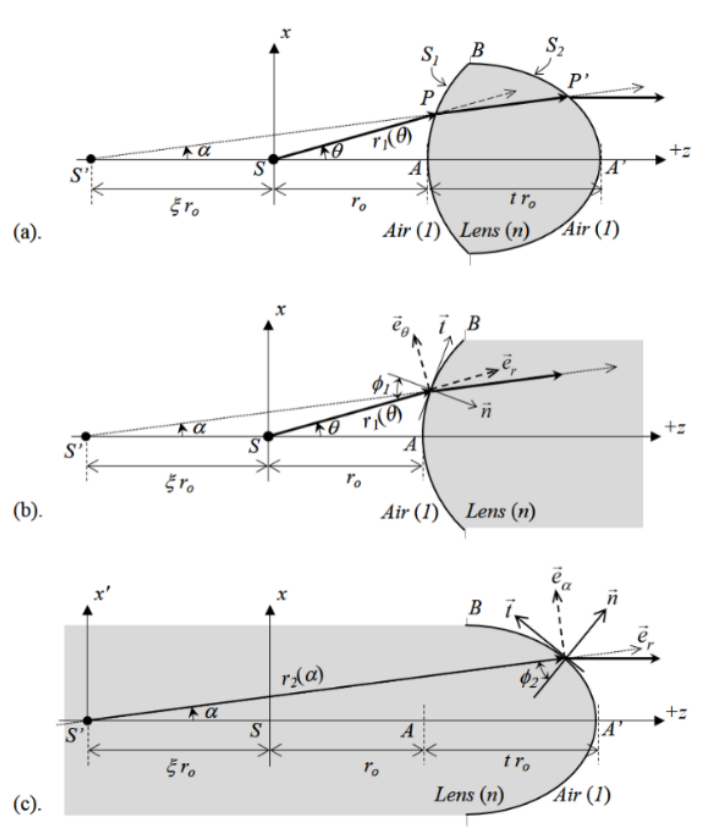
Figure A1. Double-sided analytic collimating lens for collimating light form a point source: ( a ) Overview, ( b , c ) details for constructing front ( S 1 ) and back ( S 2 ) surfaces of the